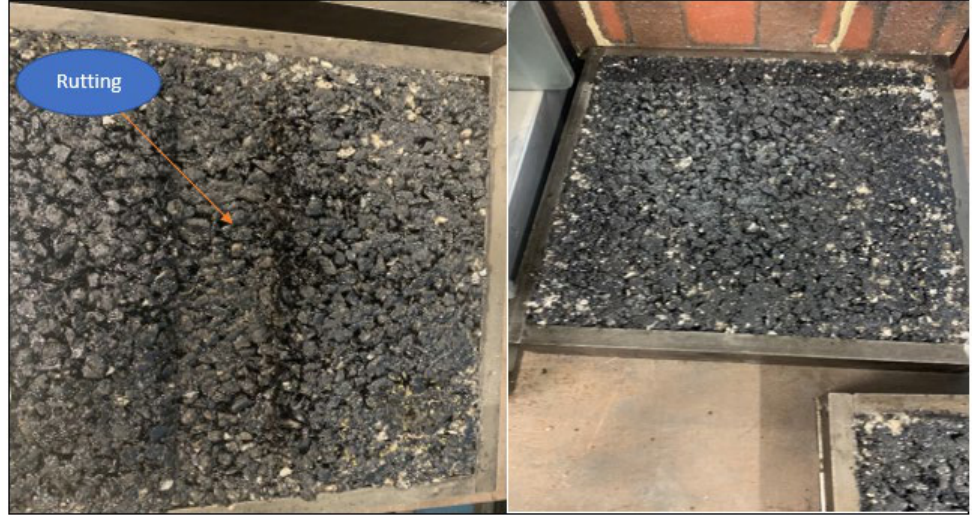
Recycling 2022 , 7 , x FOR PEER REVIEW Figure 15. Rutting deformation for 0% PET ( left ) and 8% PET-modified SMA ( right ).